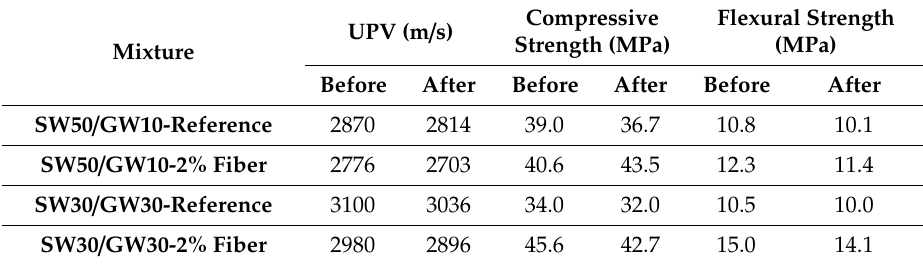
Table A2. E ff ects of Freeze / thaw tests on the hardened state properties of the reference and fiber reinforced mixtures (no